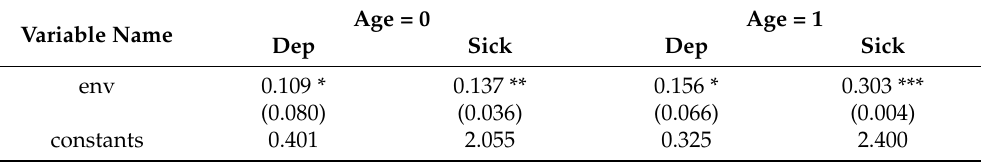
Table 9. The impact of environmental perception on the health status of different age groups. Variable Name